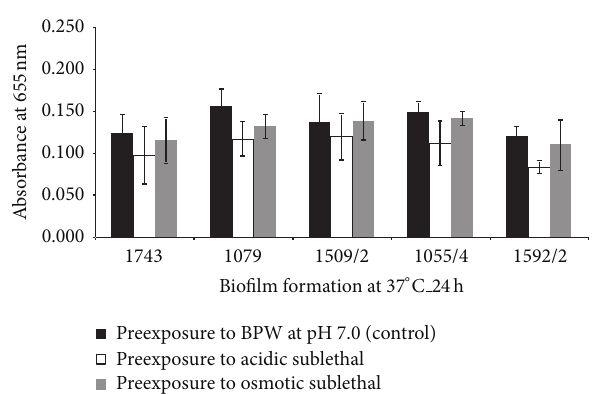
Figure 3: Values of absorbance at 655 nm obtained for five L. monocytogenes isolates after being exposed to acidic and osmotic sublethal stresses and tested for biofilm formation at 37 ∘ C during 24 h.